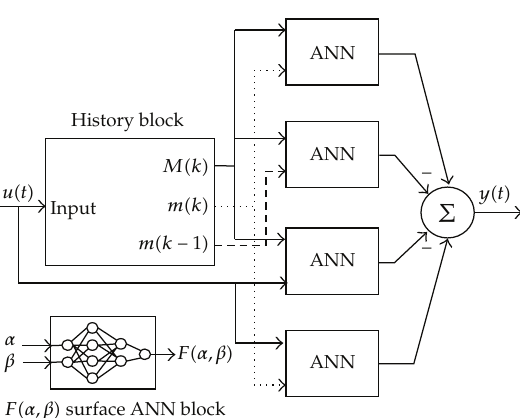
Figure 11: The proposed ANN-based Preisach